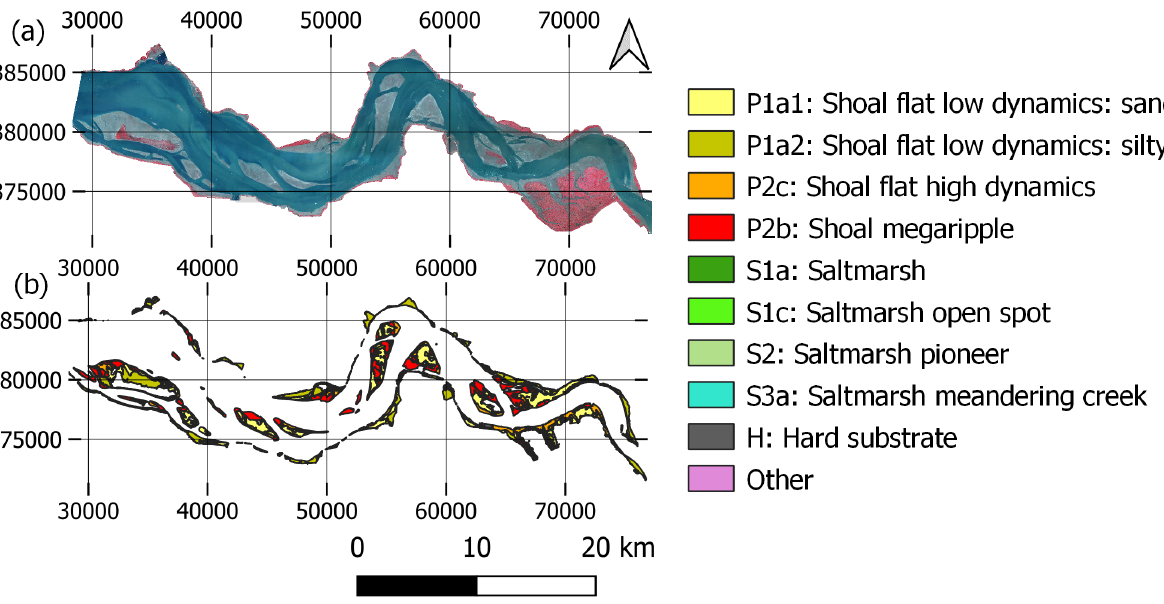
Figure 1. The Western Scheldt study area. Figure (a): false color aerial image with the red, blue, and Near-Infrared bands, 0.25 m resolution. Figure (b): the expert map and classification schemes.